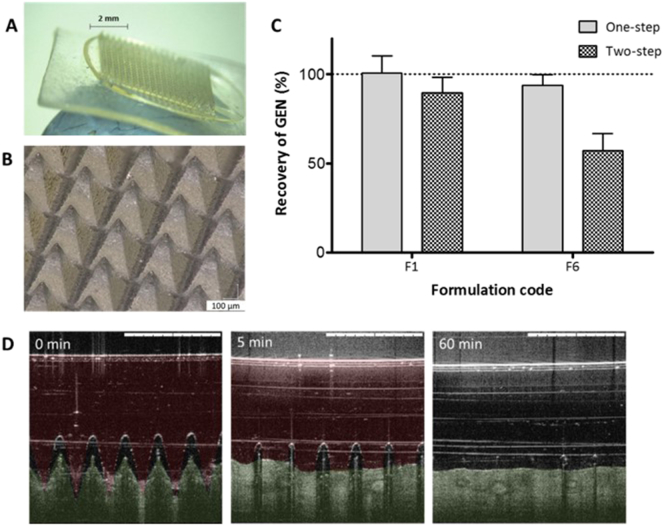
Digital pictures showing two-layered MN array taken with (A) the Leica EZ4D digital microscope and (B) the Keyence VHX-700F digital microscope (Keyence, Milton Keynes, UK). (C) Comparison of percentage recovery of GEN from dissolving MNs prepared from F1 and F6 in one-step and two-step (means ± S.D., n = 3). (D) Representative OCT images showing in vitro dissolution kinetics of a 19 × 19 MN array prepared using F1 and inserted manually in neonatal porcine skin. False colours were applied to the skin and MNs. The original OCT images can be found on the Supplementary content (Fig. S1). The white scale bar at top right represents a length of 1 mm.